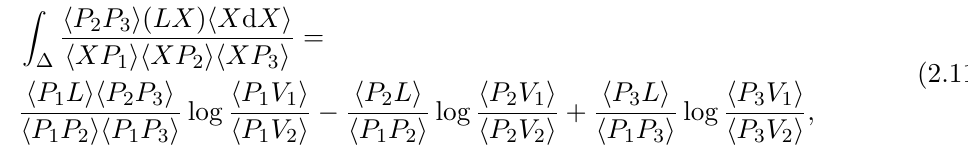
around P in the opposite direction. 1 i